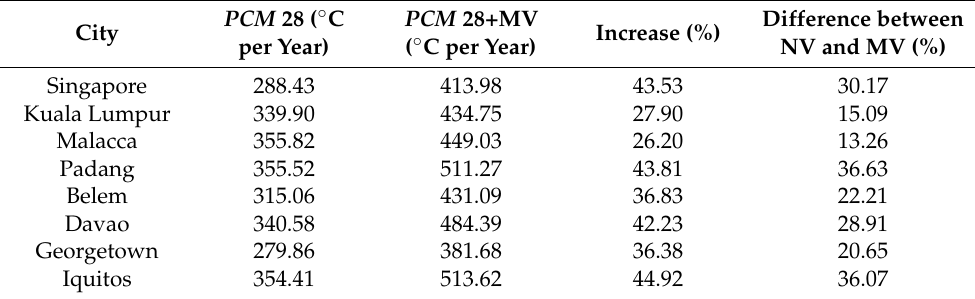
Table 6. TTD values for all the cities for the PCM 28 and PCM 28 + MV cases, and the difference in the TTD increase between PCM 28 + NV and PCM 28 +